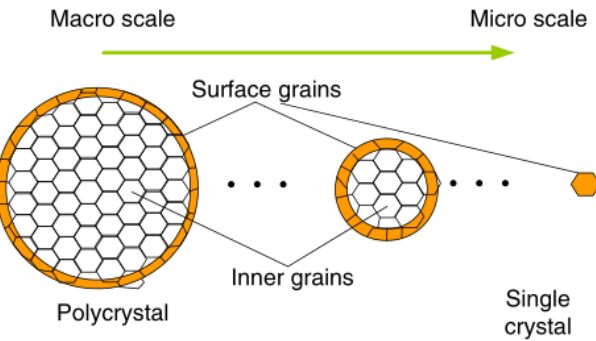
Figure 6. Particle distribution in the material cross-section varies with decreasing specimen size.